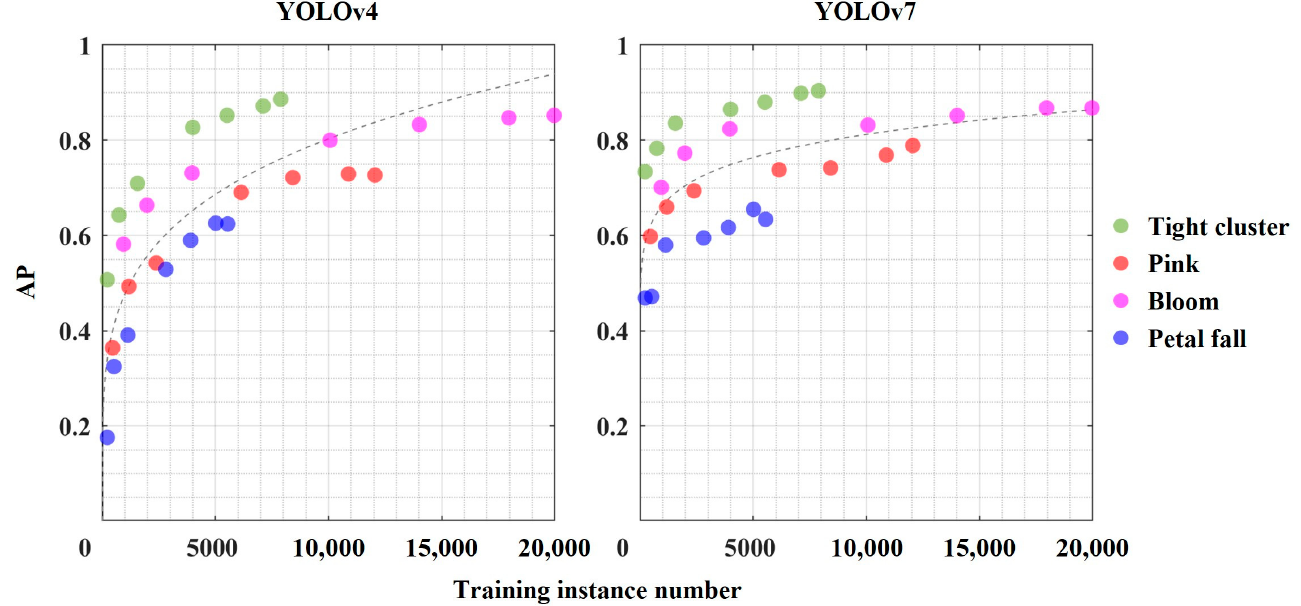
Figure 4. Relationships between training instance numbers of individual apple flower bud growth stages and model average precisions (APs) of YOLOv4 and YOLOv7 with fitted two-term power series trend lines.